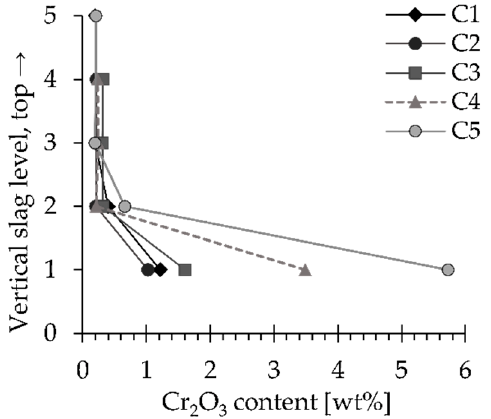
Figure 7. Chromium oxide content at all vertical slag levels at the settling end. Level 1 corresponds to the bottom-most layer in the slag bath and level 5/4 was the second-highest level in the slag